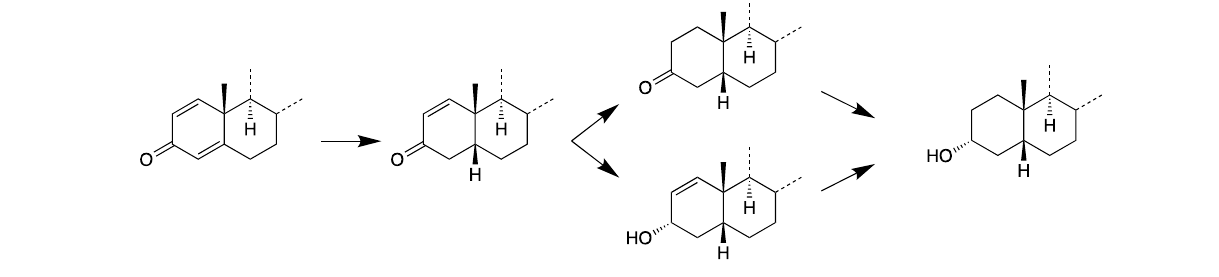
Figure 10. Potential ways of A-ring reduction.